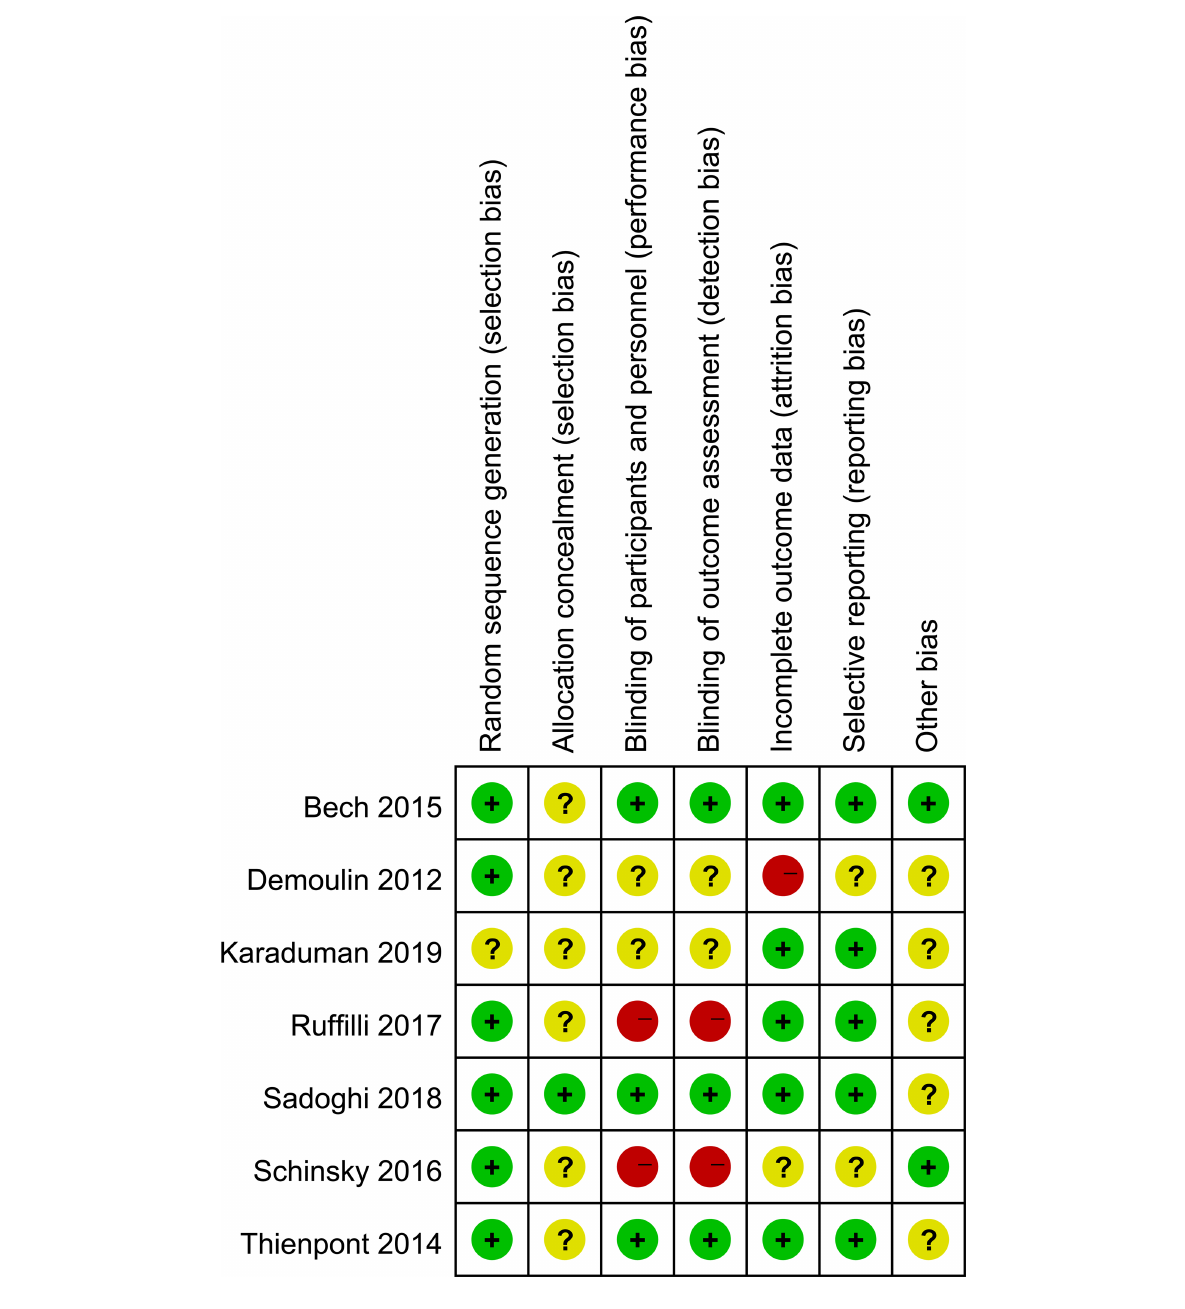
FIGURE 3 Risk of bias in individual